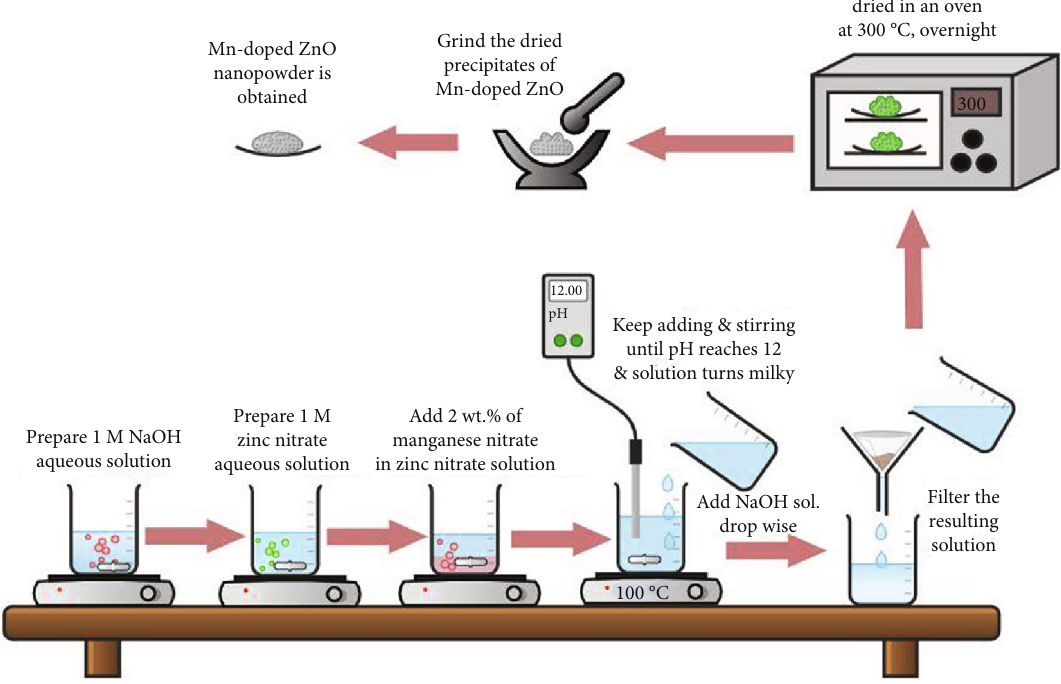
Figure 1: The synthesis route of Mn-doped ZnO nanoparticles via the chemical precipitation